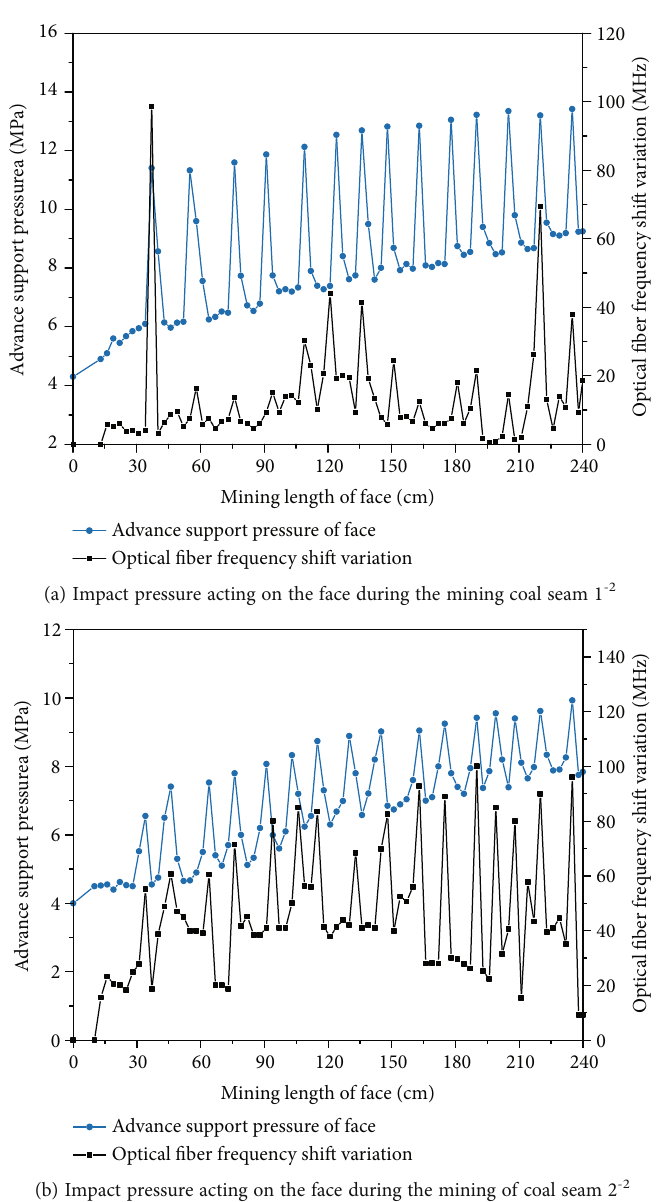
Figure 11: Comparison of the impact pressures monitored by the optical fi ber sensors and the pressure